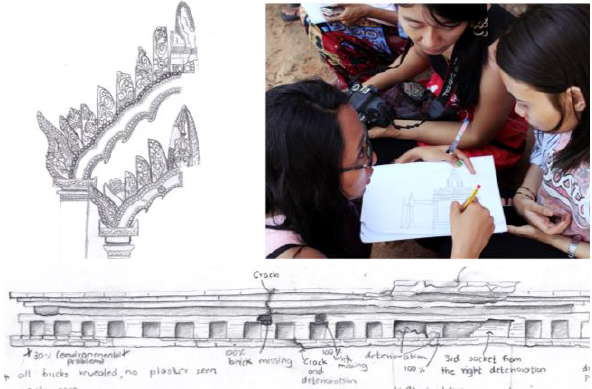
Figure 7 Examples of the field notes and sketches developed in the site.